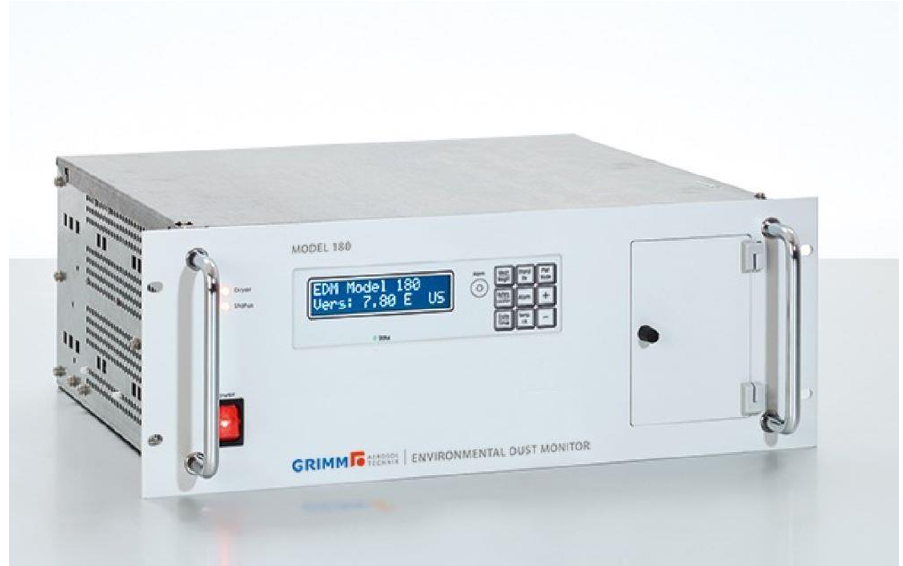
Figure 2. EDM 180 GRIMM (www.grimm-aerosol.com, accessed on 3 April 2022).